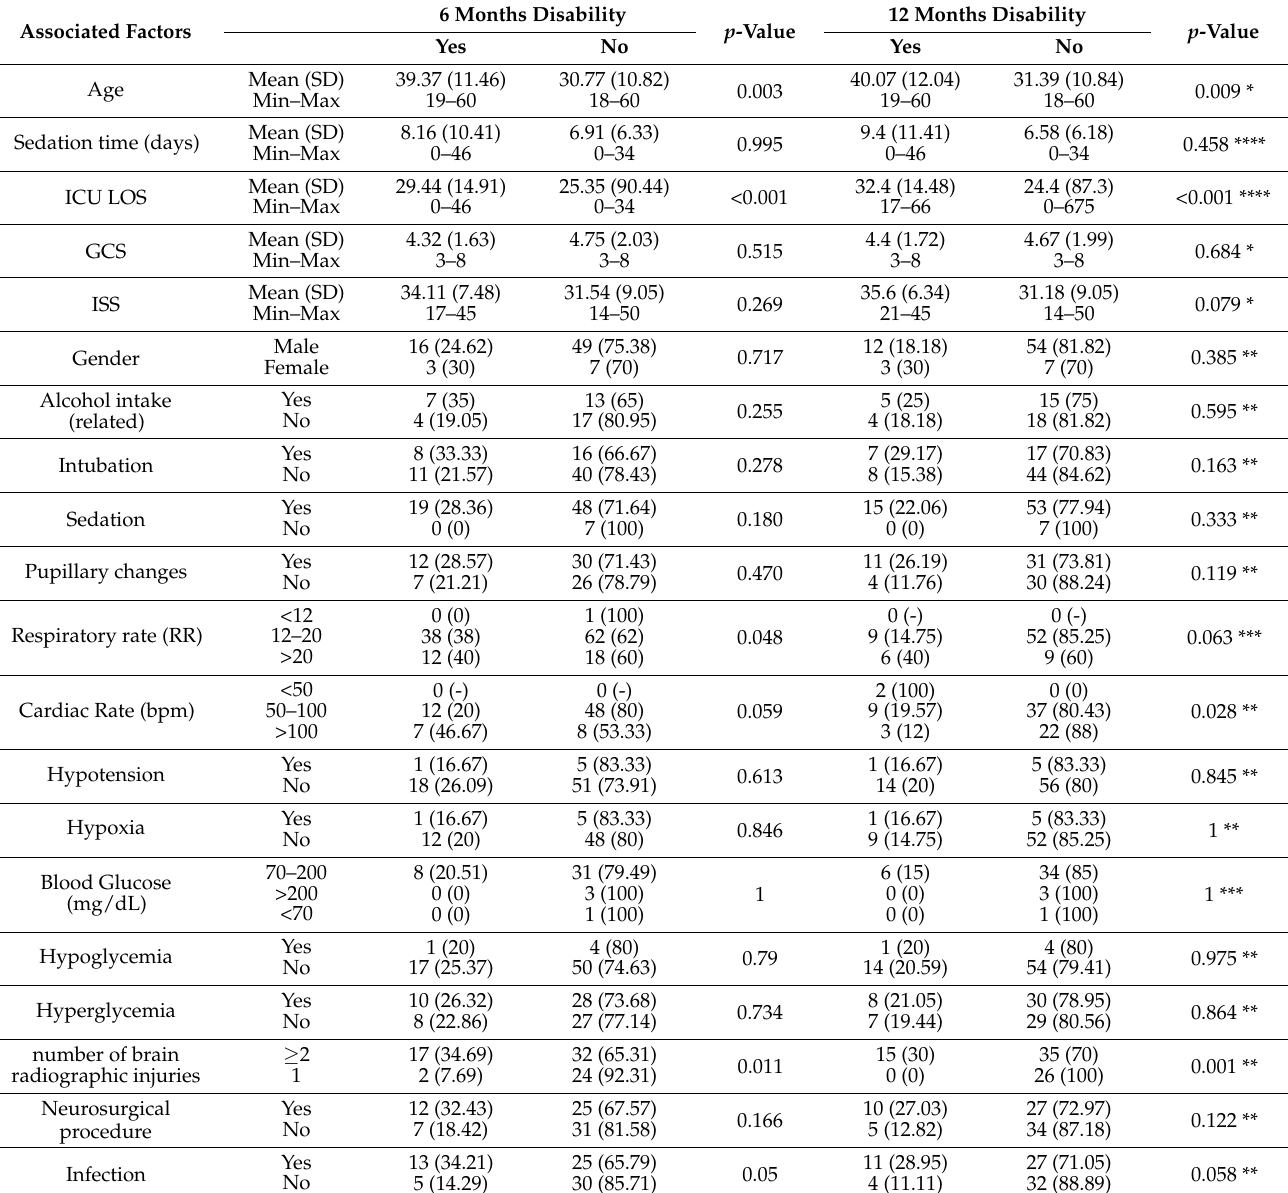
Table 5. Factors associated with functional dependence at 6 and 12 months in severe TBI victims with focal